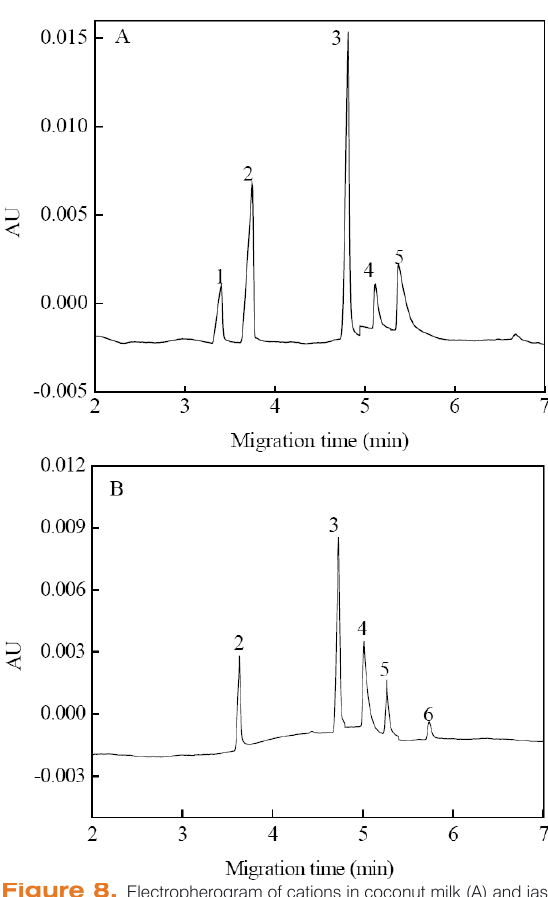
Figure 8. Electropherogram of cations in coconut milk (A) and jas- mine tea drink (B). Experimental conditions are the same as in Fig.1; the dilution factor was 1:50 (v/v).